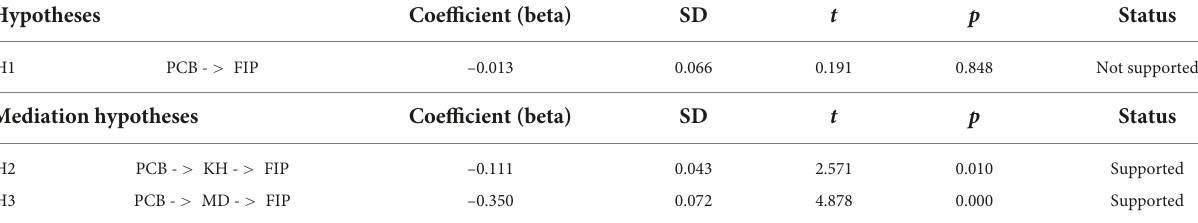
TABLE 5 Hypotheses testing